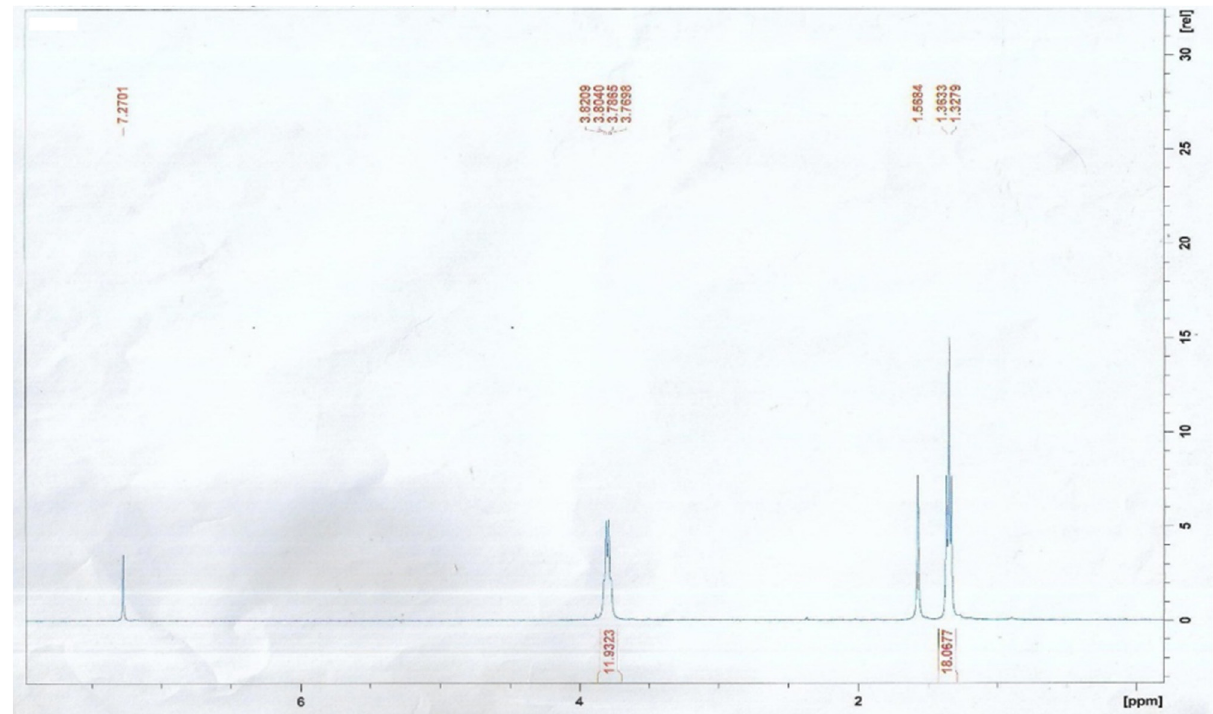
Figure A2: 1 H NMR spectrum of complex 1